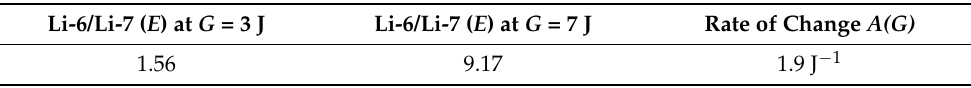
Figure 12. The figure represents the relationship between the ratio of the extracellular lithium isotopes Li-6/Li-7 ( E ) and the energy of gate G when setting L = 1 m and V m = 0.087 V. Table 32. The table shows the ratio Li-6/Li-7 ( E ) that can take the range between the two values at G = 3 J and at G = 7 J and shows the rate of change in the ratio with respect to the energy of gate G